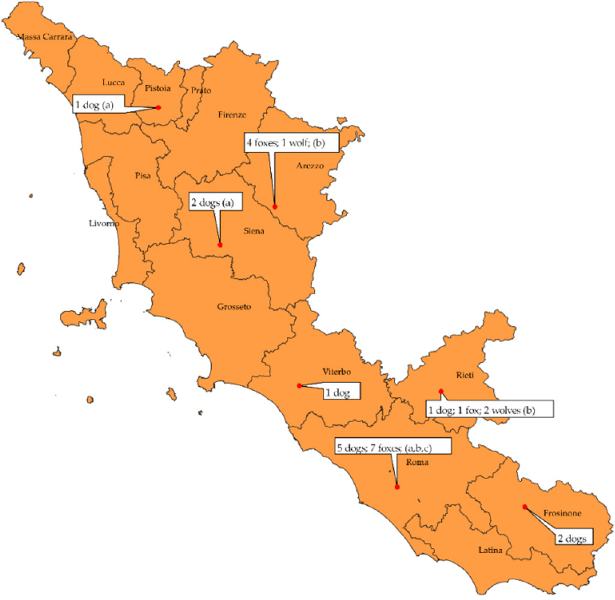
Figure 2. Distribution of positive animals by species and province of origin and identified strains.